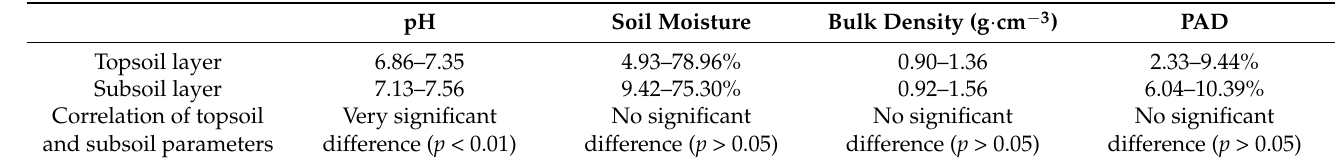
Table 2. Statistical characteristics of some soil parameters in the Yinna mountainous